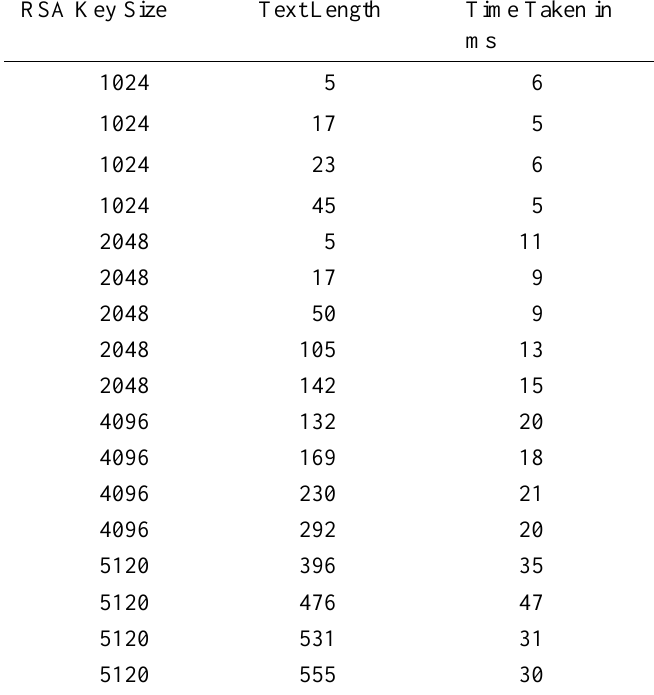
Table 1. Time taken for different key size with different